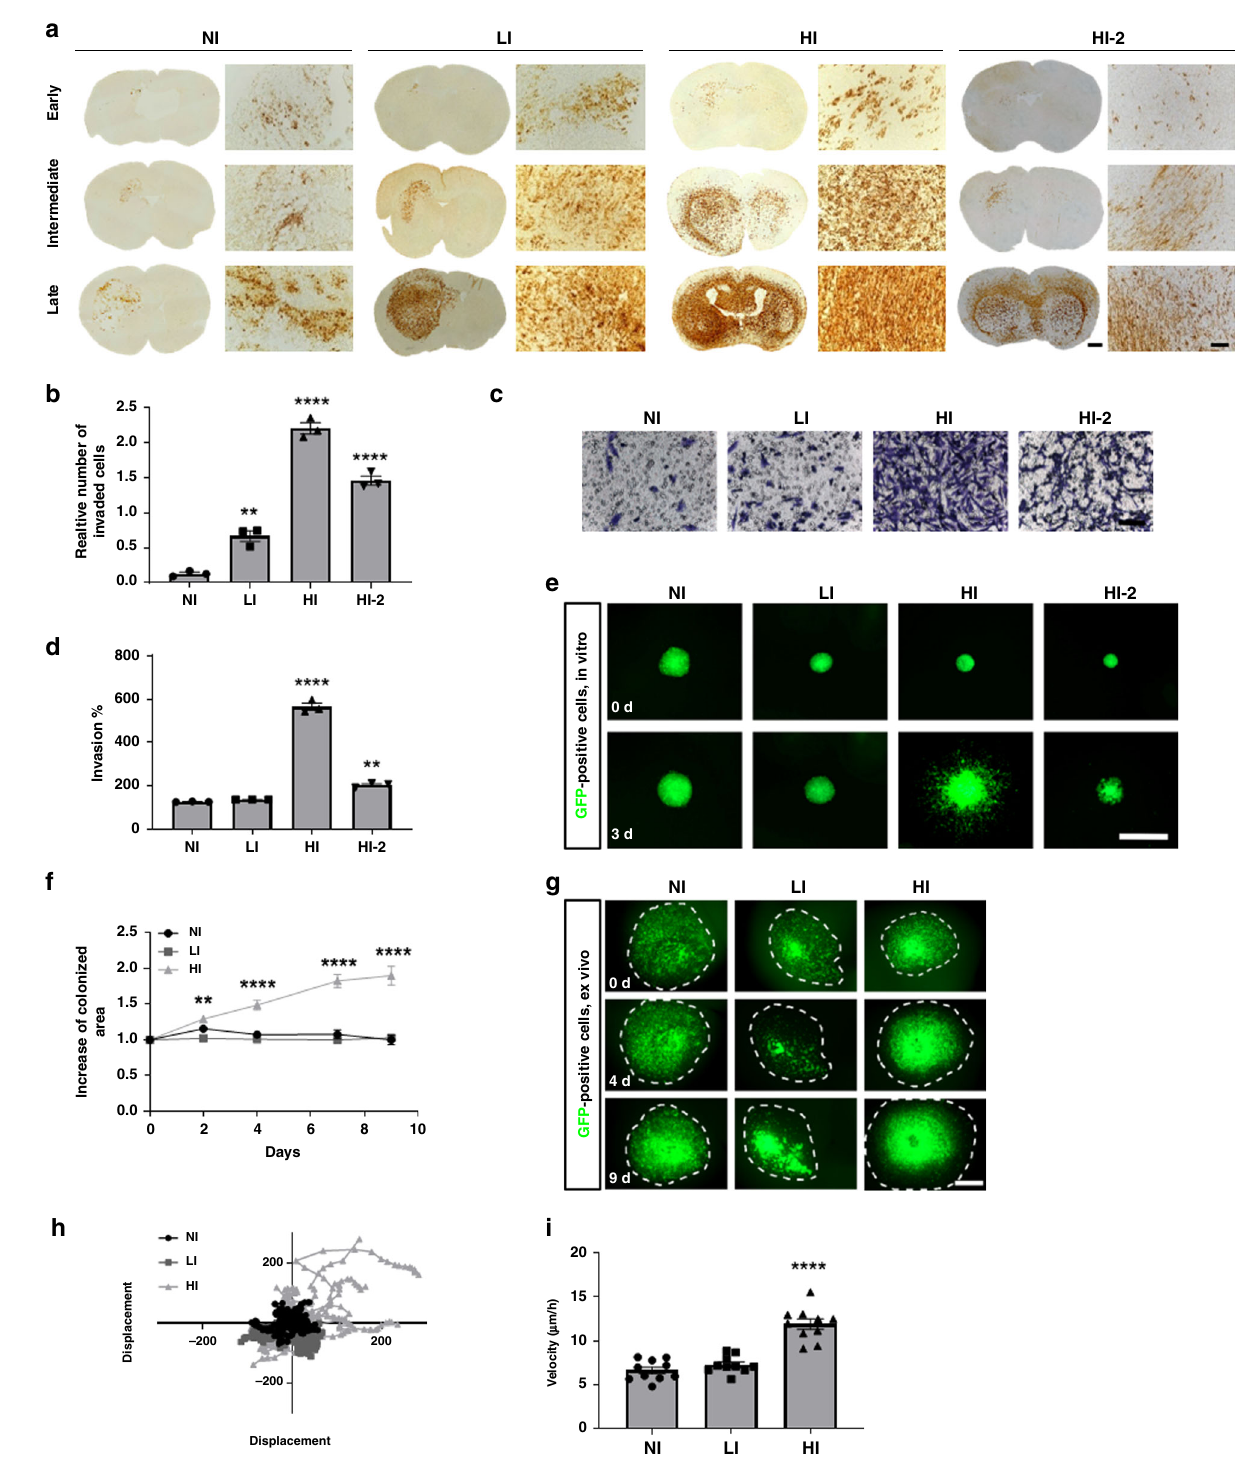
Fig. 1 Patient-derived GBM stem-like cells (GSCs) display different invasion phenotypes in vivo, which are recapitulated in in vitro and ex vivo assays. a Early, intermediate and late time point of different GSC orthotopic xenografts in mice displaying non invasive (NI), low invasive (LI) and highly invasive (HI, HI-2) phenotypes. Respective tumor development times were 5 weeks (NI), 8 weeks (LI) and 25 weeks (HI, HI-2). Anti-human vimentin staining was used to visualize tumor cells (Scale bars = 100 µ m and 1000 µ m for overview). ( n = 2 mice for each tumor and time point with n = 3-4 sections per mouse). b In vitro Boyden Chamber invasion assay, displaying the relative number of invaded cells ( n = 3). c Representative pictures of in vitro Boyden chamber invasion assay re fl ecting the different invasion phenotypes. Scale bar 100 µ m. d Quanti fi cation of invasion of GSCs in 3D sprouting assay ( n = 3). e Representative pictures of sprouting assay of different GFP-positive GSCs ( n = 3) (Scale bar = 1000 µ m). GFP: Green fl uorescent protein. f Quanti fi cation of increase of colonized area of GSCs in ex vivo brain slice cultures, 9 days after tumor implantation ( n = 10). g Representative pictures of GSCs in ex vivo brain slice cultures at day 0, 4, and 9 (Scale bar = 1000 µ m). h Displacement of GSCs injected into ex vivo brain slice cultures ( n = 10). i Velocity of GSCs in ex vivo brain slice cultures. Results of ( b , d , f are i ) displayed as average± SEM and were analyzed with one-way ANOVA. ** p value < 0.01, **** p value <